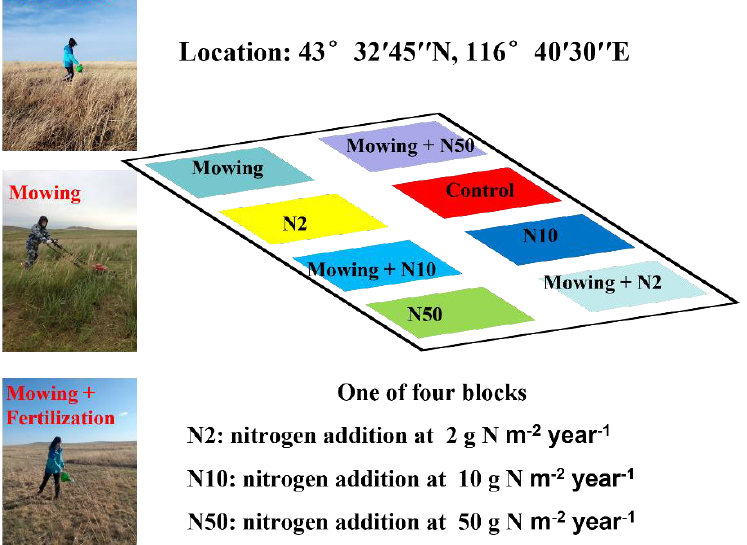
Figure 7. Map of the nitrogen addition and mowing treatment plots.